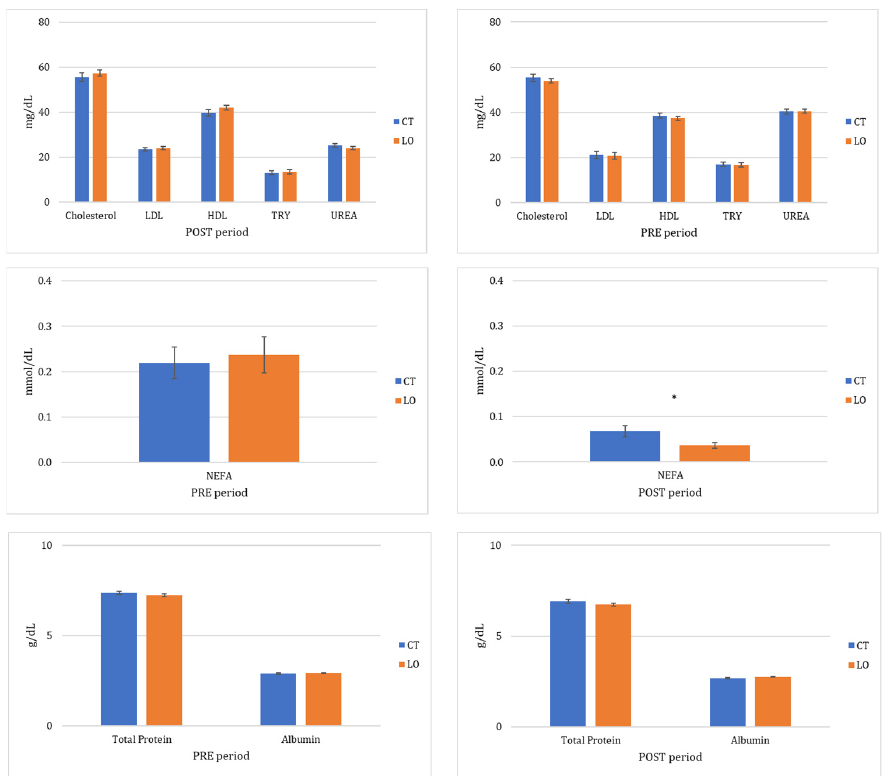
Figure 1. Circulating levels of cholesterol, HDL, LDL triglycerides, NEFAs, total protein, albumin, and urea in Sarda dairy ewes non-supplemented (CT) and supplemented with bypass linseed oil (LO; on PRE and POST periods). An asterisk (*) indicates differences between groups within a period at p < 0.05.